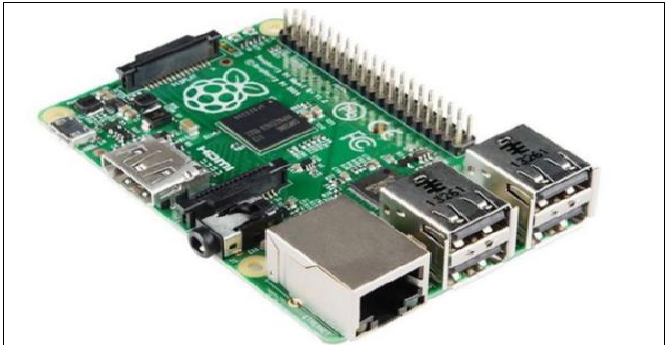
Figure 6: Raspberry Pi 1 Model B+ rev 1.2. Source: Taken from [31].